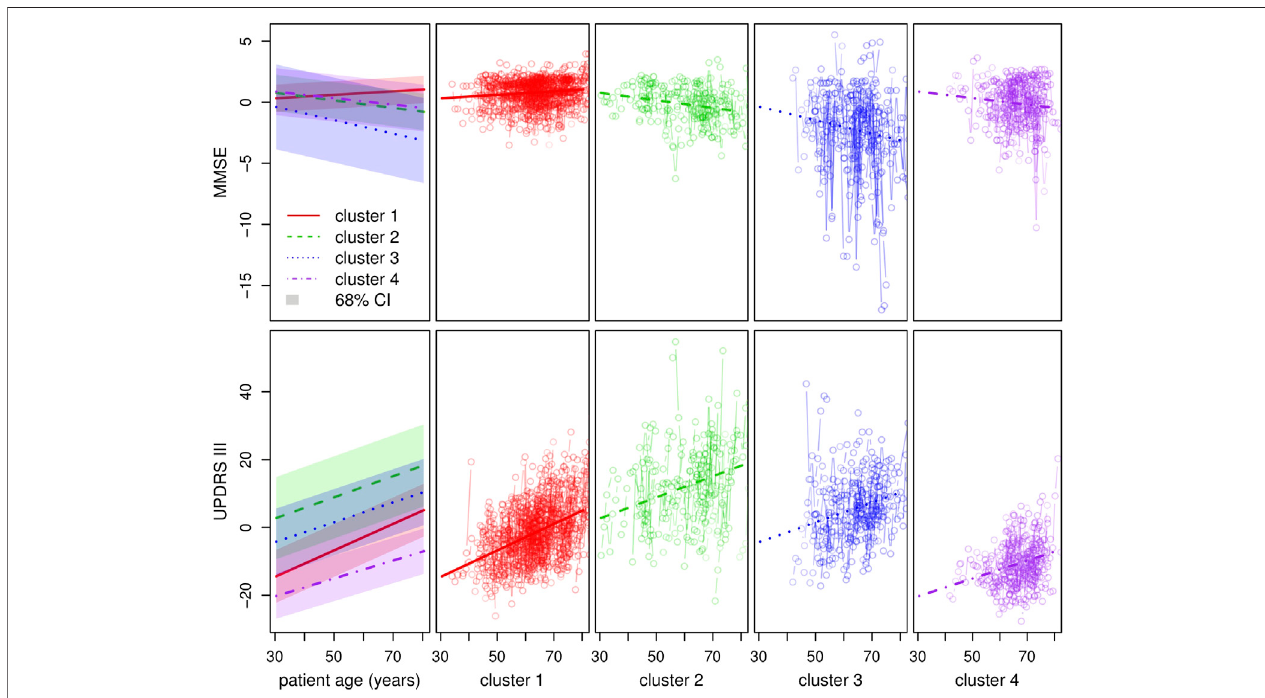
FIGURE 5 | Clustering with regard to the clinical variables. The top and bottom left-hand graphs show the fi tted trajectories (straight lines) for each of the four clusters and the corresponding 68% con fi dence intervals obtained by adding and subtracting the fi tted σ parameters. The top y -axis represents the MMSE score (evaluation of cognitive impairment) and the bottom y -axis the UPDRS III score (motor evaluation). The other graphs show in detail, for each cluster and each score around the standard trajectory, all the trajectories of the patients assigned to the cluster.